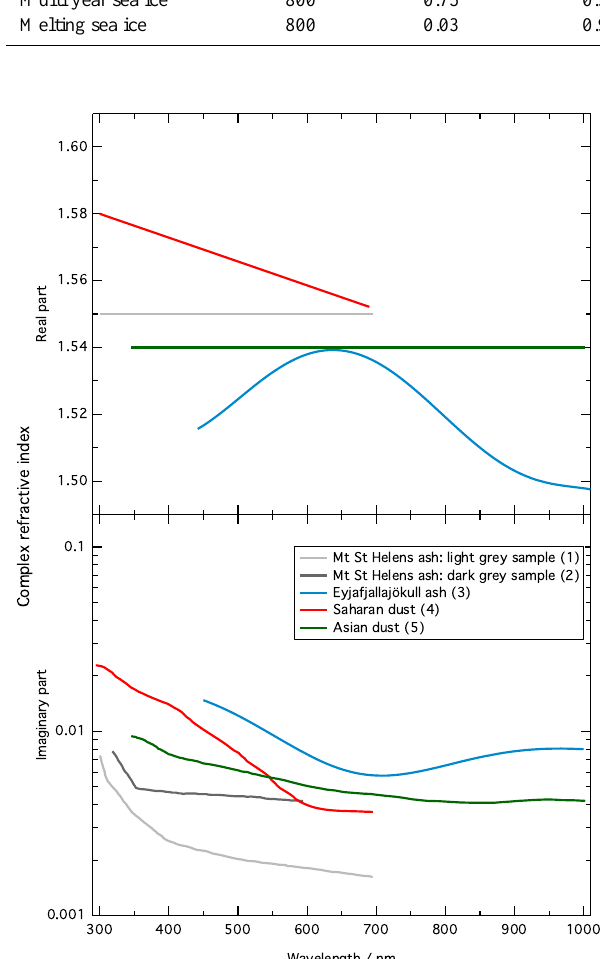
Figure 1. Complex refractive index (real and imaginary part) for mineral aerosol deposits as a function of wavelength. Values are based on work by Derimian et al. (2012) (3) , Patterson and Gillette (1977) (4) , Patterson (1981) (1, 2) and Sokolik et al. (1993) (5) .